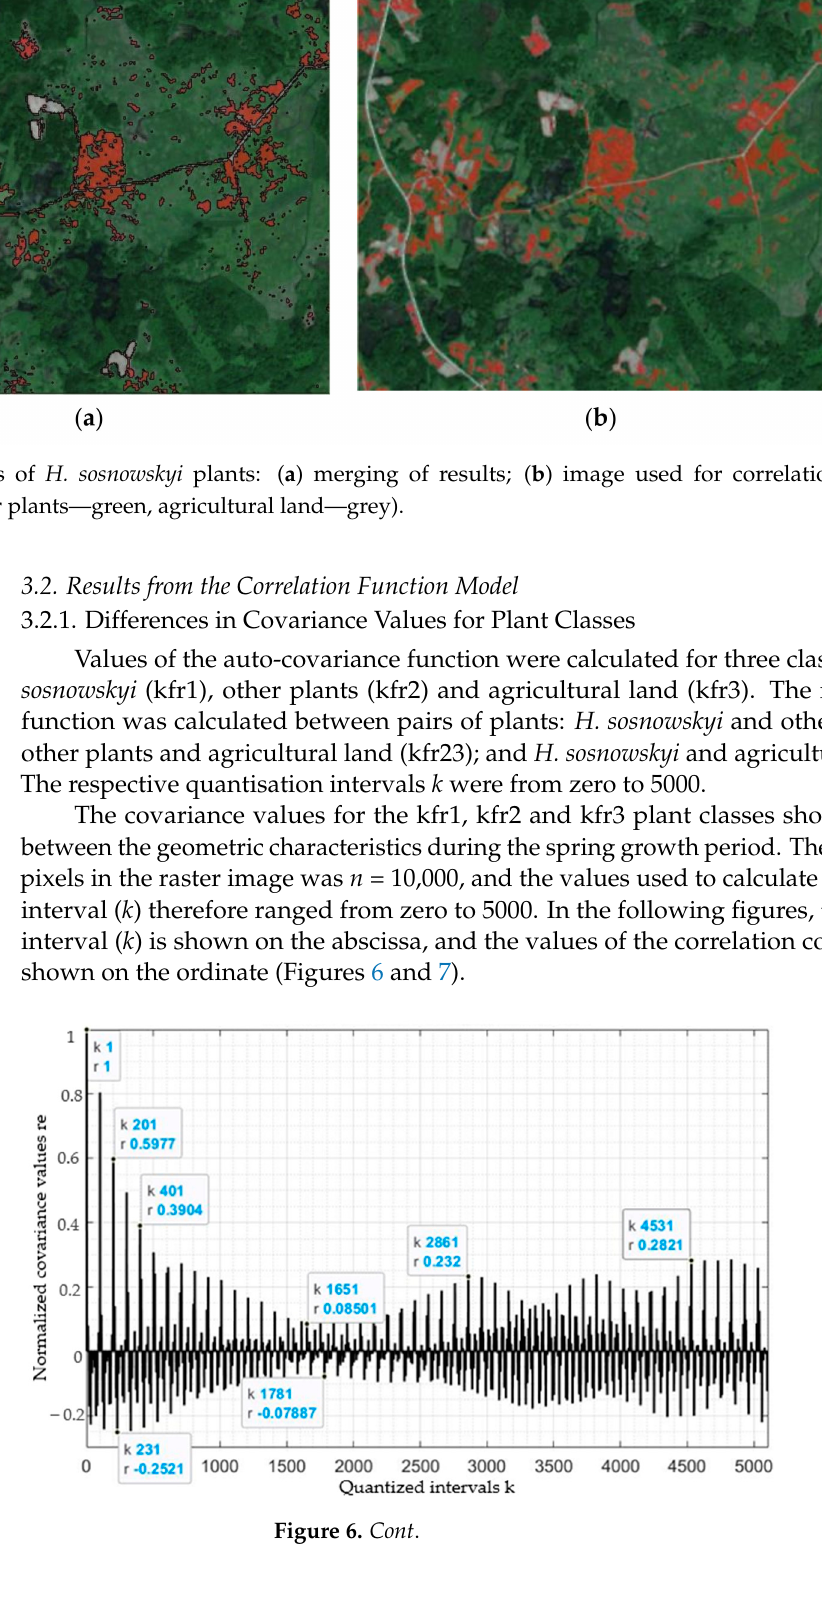
( b ) ( c ) Figure 6. Pixel vector auto-covariance functions: ( a ) kfr1— H. sosnowskyi plants (shown in red in Figure 5); ( b ) kfr2—other plants (shown in green in Figure 5); ( c ) kfr3—agricultural land (shown in grey in Figure 5).